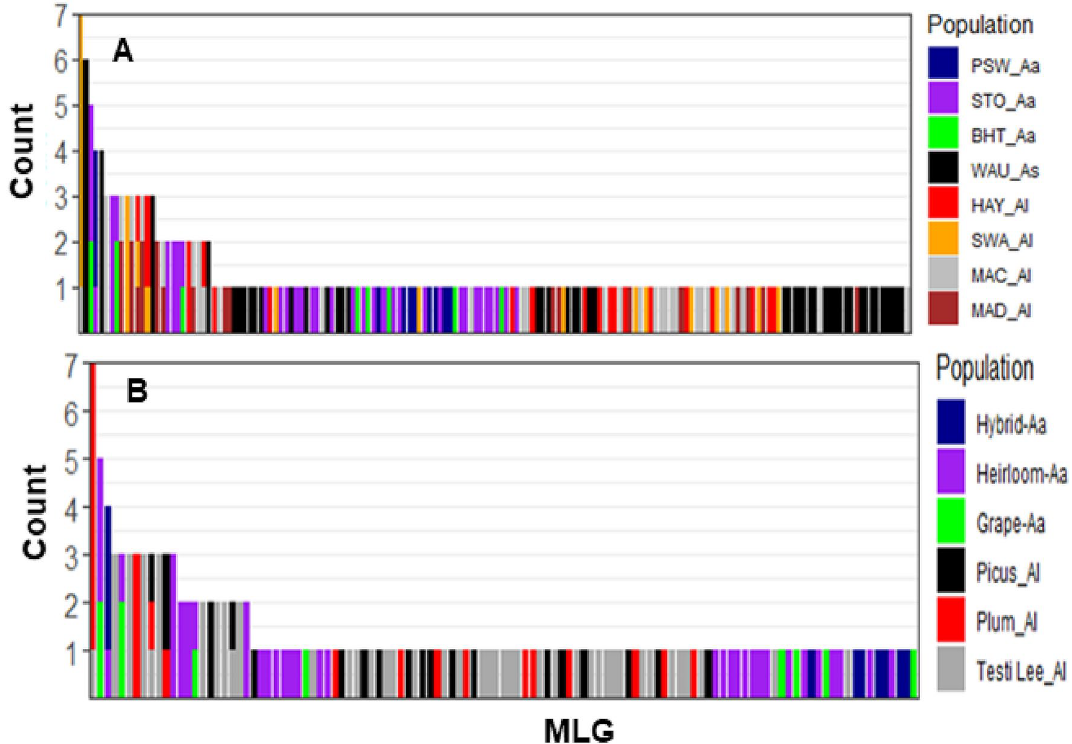
Figure 2. Bar plot showing the abundances of single nucleotide polymorphism (SNP)-based genotypes (MLGs) shared between geographic location populations of three Alternaria species ( A ) and tomato variety populations within a species ( B ). Each bar represents a unique MLG and the number of isolates in a population, with the coloured portions of each bar corresponding to the number of isolates with that MLG in each